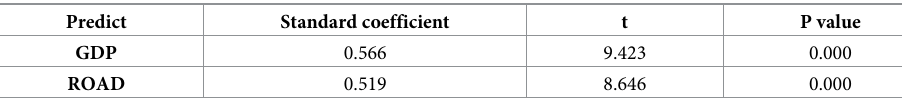
Table 9. Multiple regression coefficient of total NTL in China and